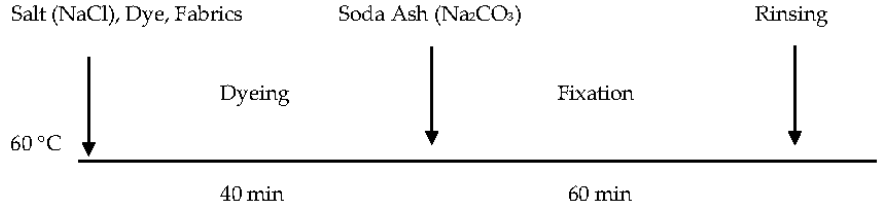
Figure 1. Dyeing profile of cotton in water.